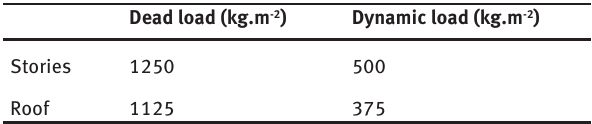
Table 1: Dead and dynamic loads of stories and roofs.